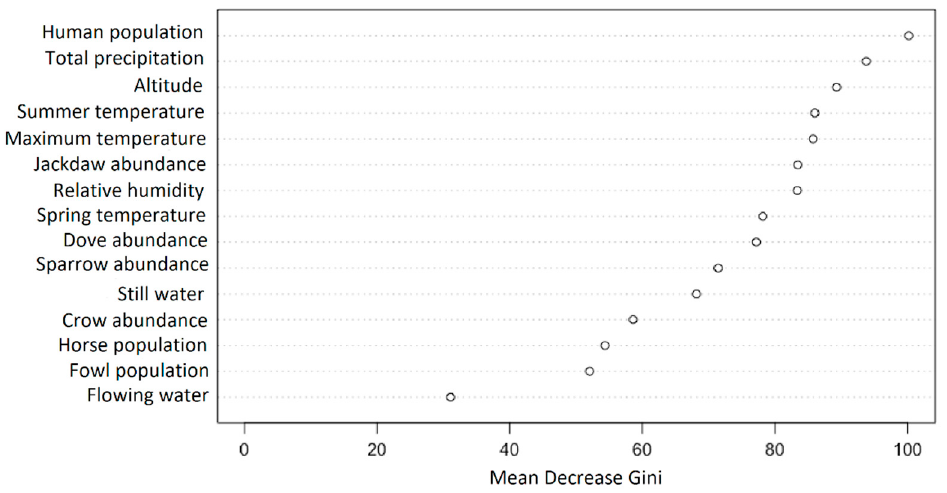
Figure 9. Variable importance for predicting the presence of human WNND cases.